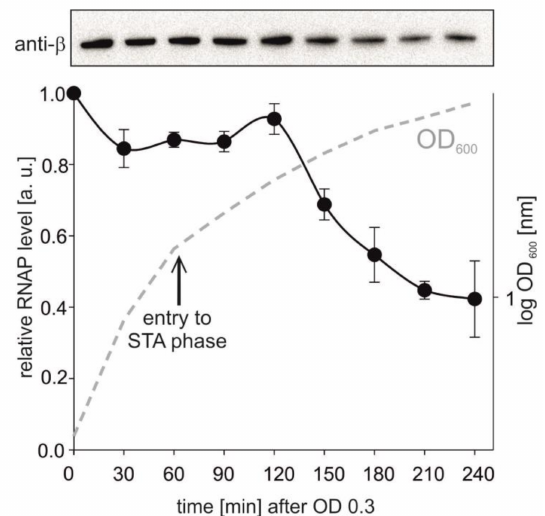
Figure 5. RNAP levels during bacterial growth. Amounts of RNAP were detected by Western blotting from 5 µ g of total protein per lane. Representative primary data are shown above the graph. The RNAP level from time point 1 was set as a 1. STA—stationary phase (indicated with the arrow). The experiment was conducted in two independents replicas. The points are averages, the error bars show the range. The dashed line shows a representative bacterial